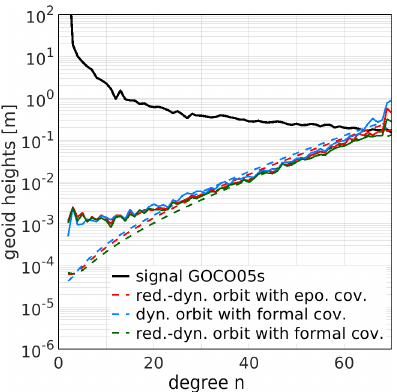
Figure 6. GRACE GPS-only gravity field solution for April 2007. Covariances considering correlations over 50min from the purely formal variance propagation in the determination of the kinematic positions are used to weight the kinematic